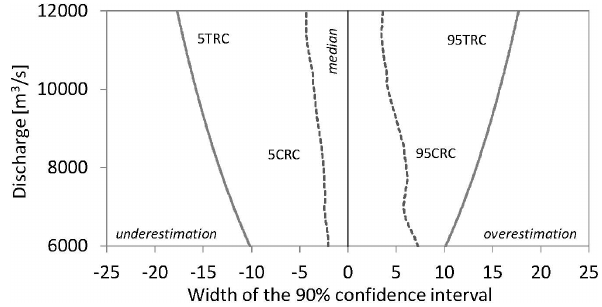
Fig. 7. Bias of Traditional (grey line) and Constrained (dashed line) median rating-curve relative to the normal rating-curve (see Fig. 5).